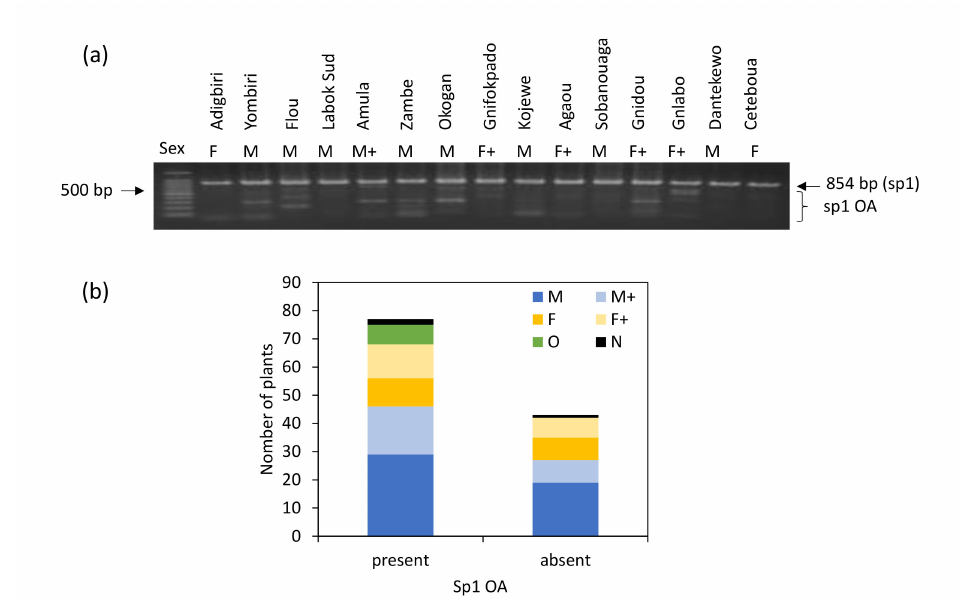
Figure 4. Presence of multiple amplifications for the sp1 marker before restriction in some cultivars of D. rotundata from Benin. ( a ) PCR amplification of sp1 before restriction in a few cultivars. ( b ) Distribution of individuals according to their sex identity and the presence or absence of multiple bands for the sp1 marker (sp1 OA) before restriction. M, stable male; M + , unstable male; F, stable female; F + , unstable female; O, monoecious; and N, non-flowering. Table 2. Impact of the presence of the sp16 marker and the secondary amplifications for the sp1 marker (sp1 OA) on the frequency of unstable male (M + ) and female (F + ) individuals of D. rotundata from Benin. Male (M + ) Female (F + ) sp1OA absent sp1OA present sp1OA absent sp1OA present sp16 absent 12.50%